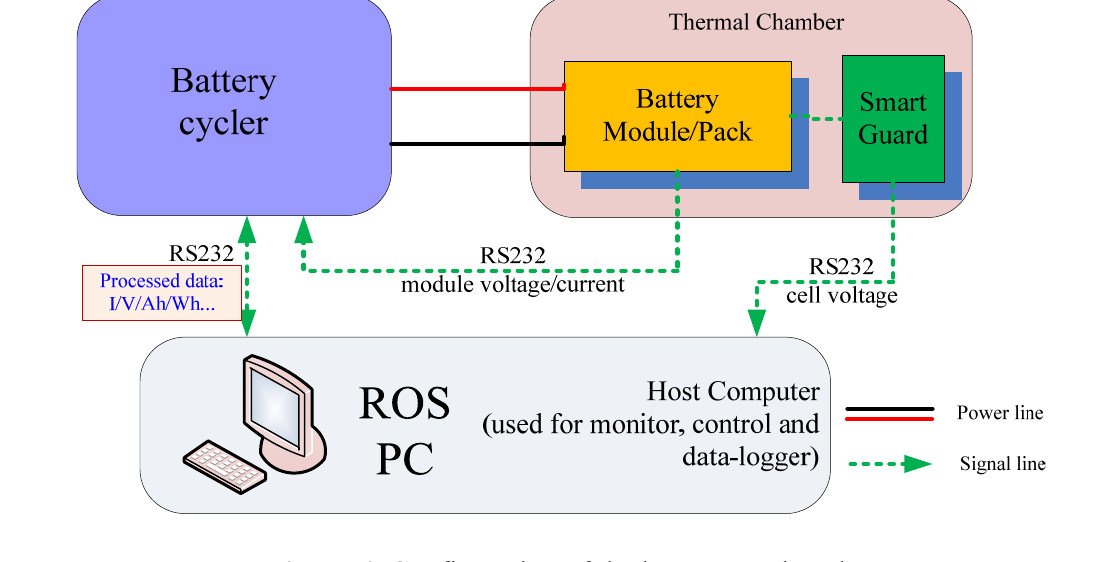
Figure 4. Configuration of the battery test bench. Table 5. Main specifications of the test